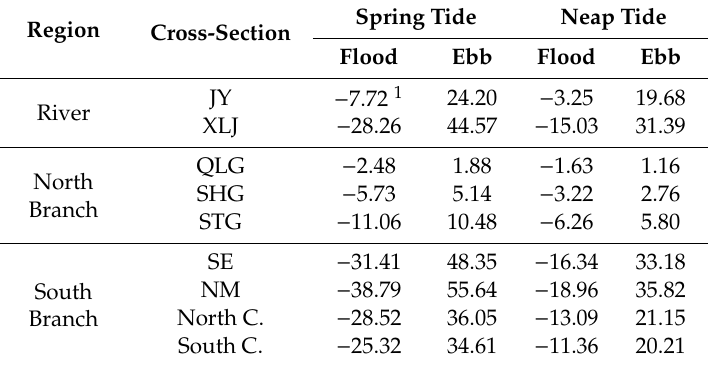
Table 2. Cross-sectional water fluxes ( CSWF ) at tide stations (unit: × 10 8 m 3 / day). Spring Tide Neap Tide Region Cross-Section Flood Ebb Flood Ebb JY − 7.72 1 24.20 River XLJ − 28.26 44.57 North Branch